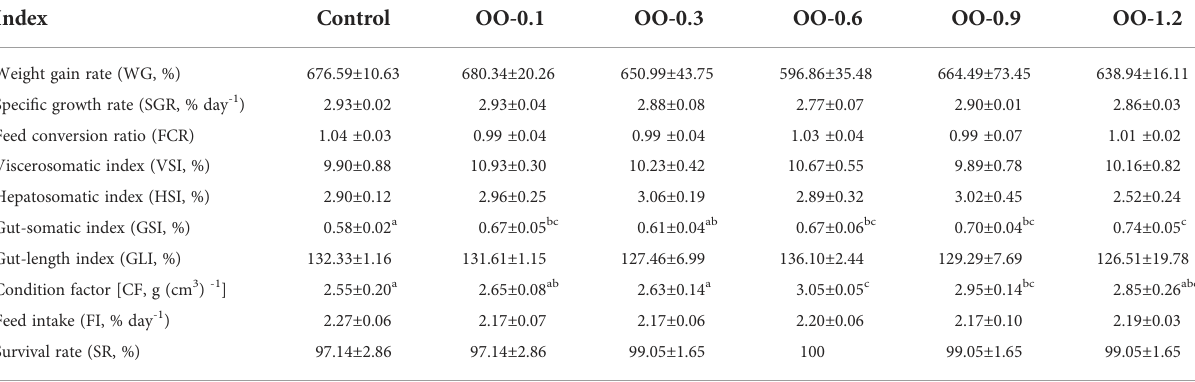
TABLE 3 Effect of dietary OO on growth performance and body indices of juvenile hybrid grouper fed the experimental diets for 8